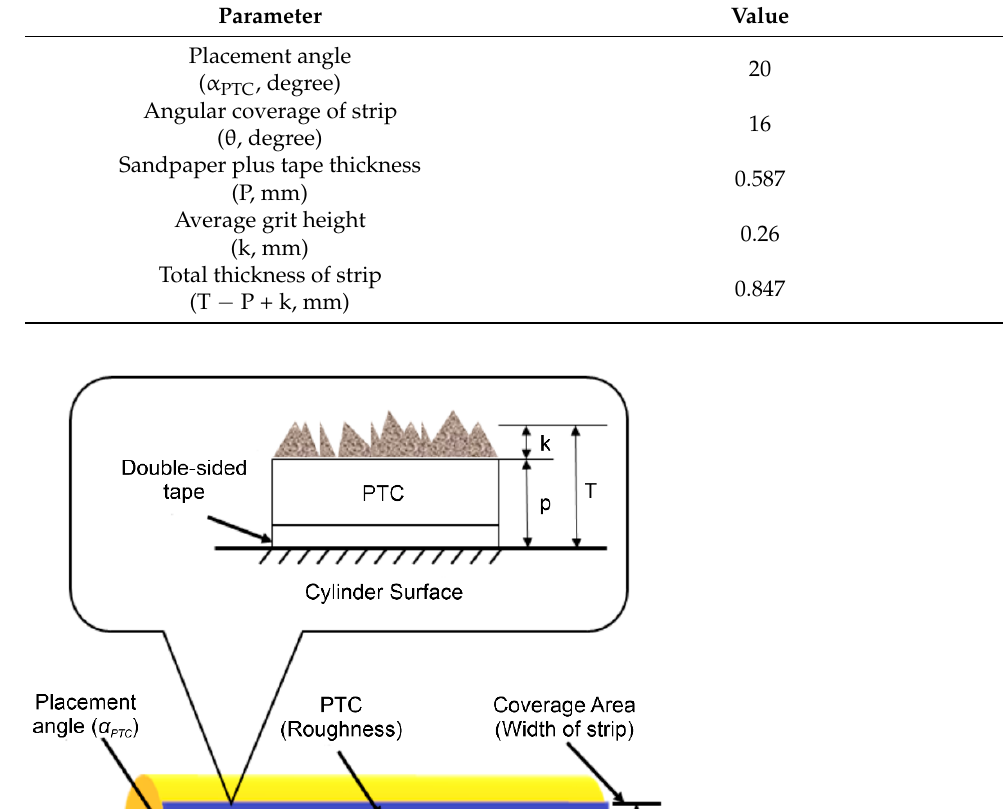
Table 1. PTC parameters (P60).